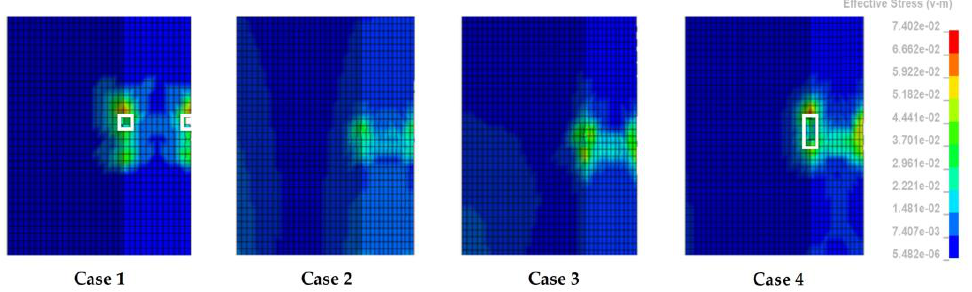
Figure 29. Stress nephograms of bridge pier in different cases.